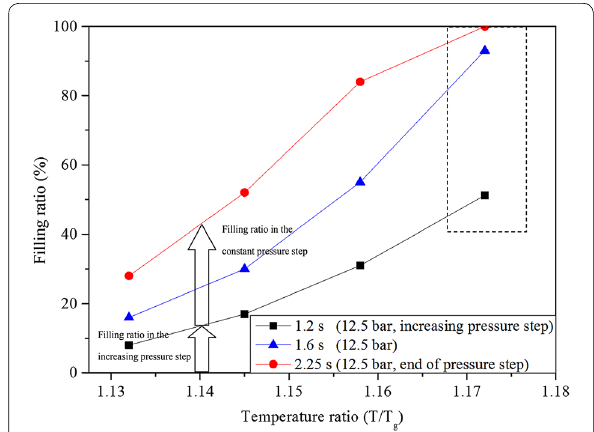
Fig. 7 Filling ratio according to the temperature ratio. (Thick‑ ness 300 nm; pressure variation rate = time step 2.25 s) =